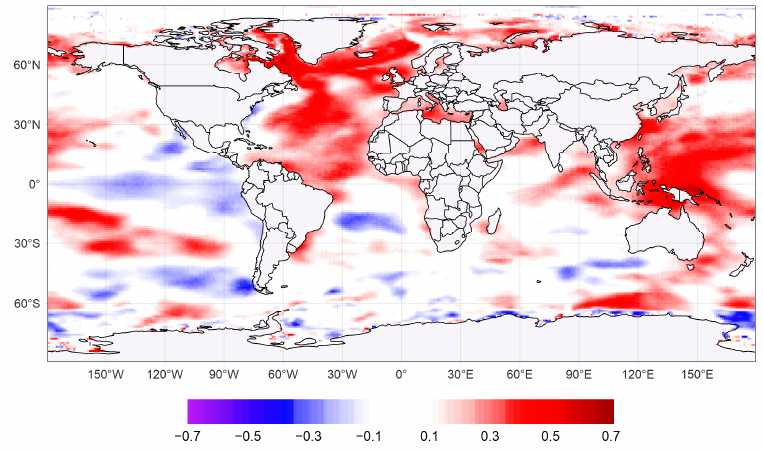
Figure 8. Spatial correlation between the annual maximum northern extent of ETCs and the annual mean SST.